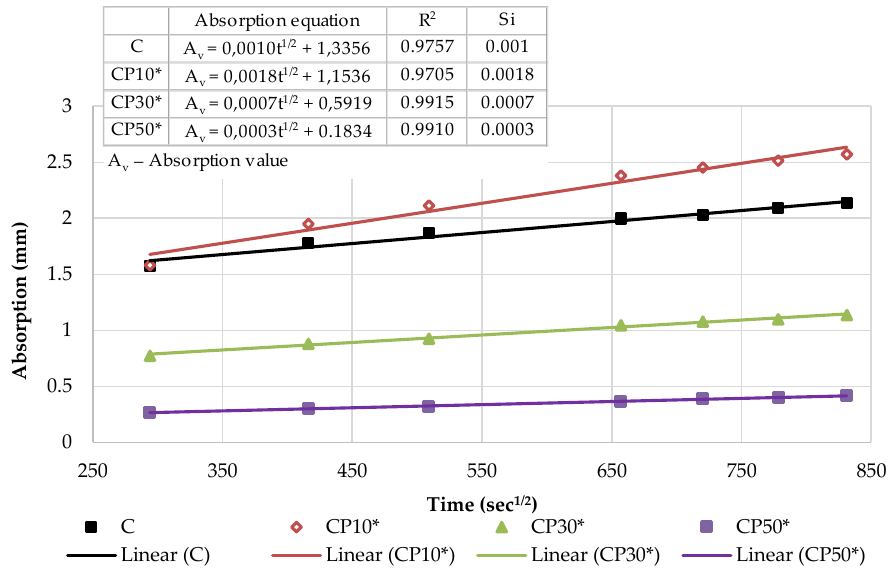
Figure 20. The secondary capillary absorptivity of CP–based mortars with decreased w/b.